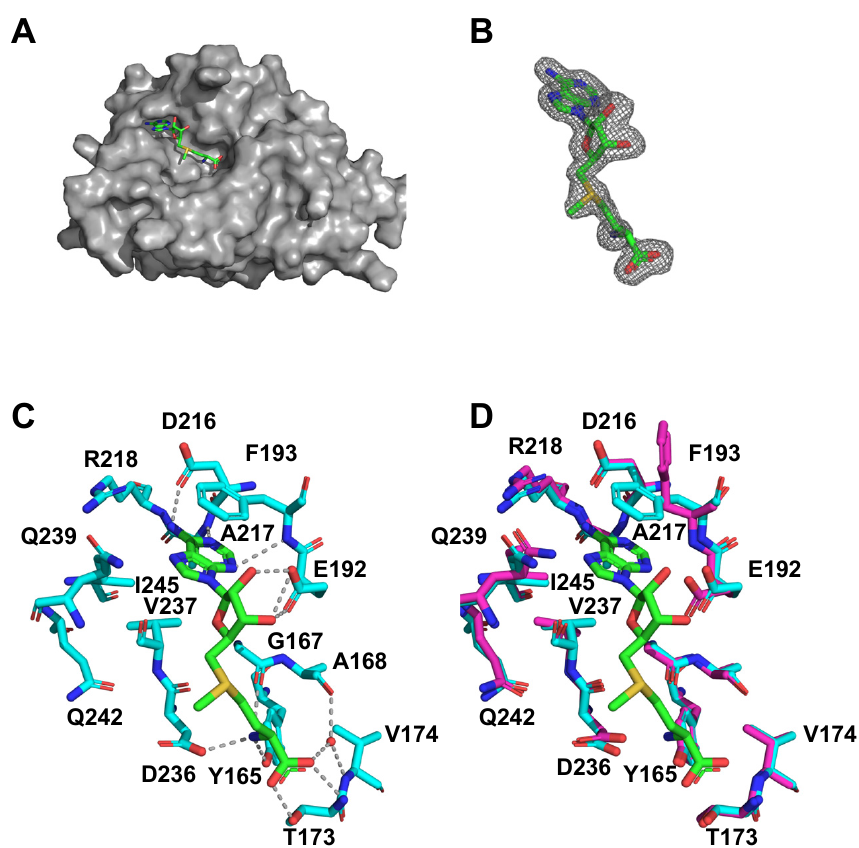
Figure 2. hFBL SAM crystal structure. ( A ) Surface representation (grey) of the hFBL SAM complex. SAM is shown in stick representation (green). ( B ) Standard omit mFo-DFc map (grey mesh, contoured at 3.0 σ ) of the SAM molecule. ( C ) Stick representation of SAM (green) and residues in the cofactor binding pocket of hFBL (cyan). ( D ) Superimposition of the hFBL SAM (cyan) and hFBL Apo (purple) structures. Oxygen, nitrogen and sulphur atoms are coloured in red, blue, and orange,